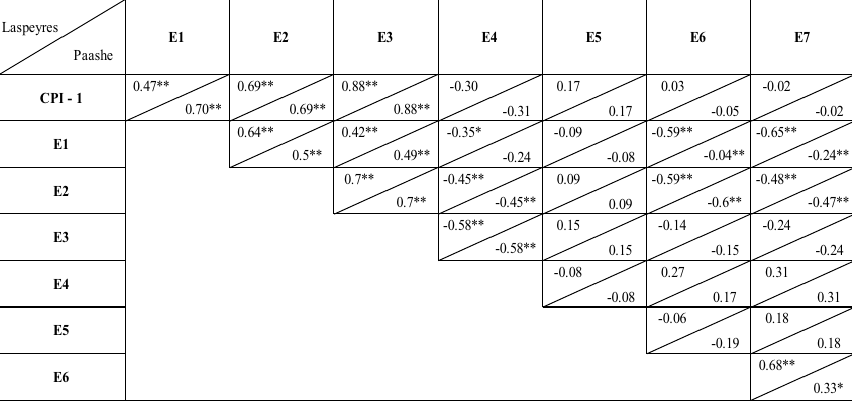
Table 1. Linear correlation between the components Laspeyres